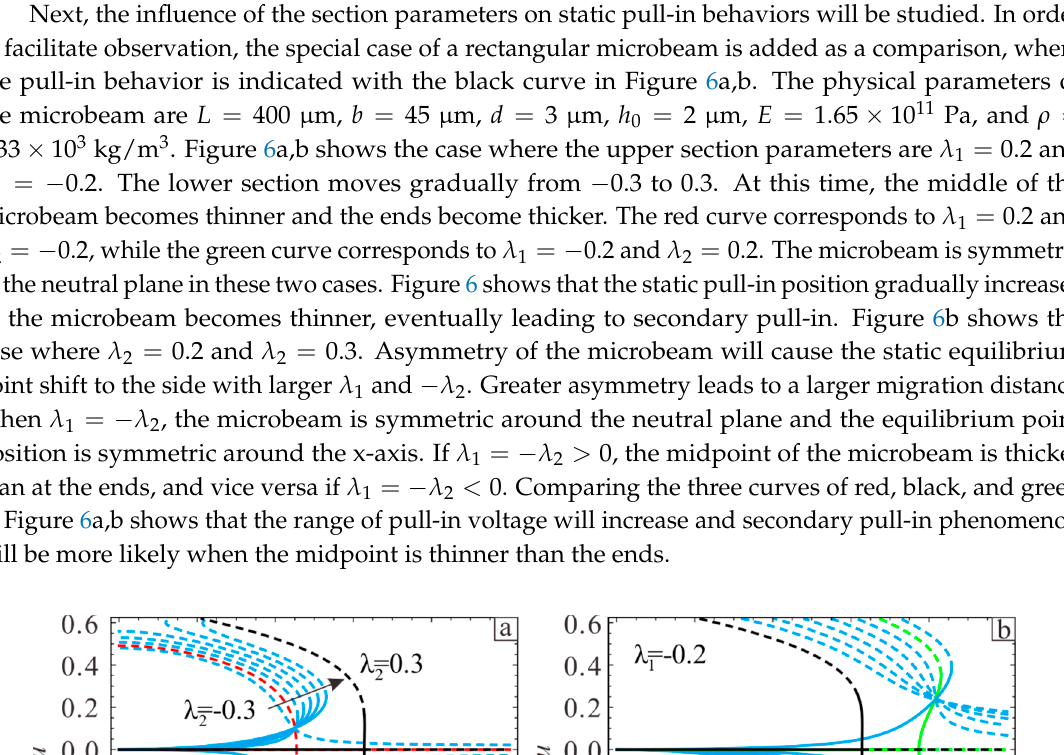
Figure 5. The relationship between the DC voltage and potential energy for different values of section parameters. ( a ) the case of λ 1 = − 0.2; ( b ) the case of λ 1 = 0.2.